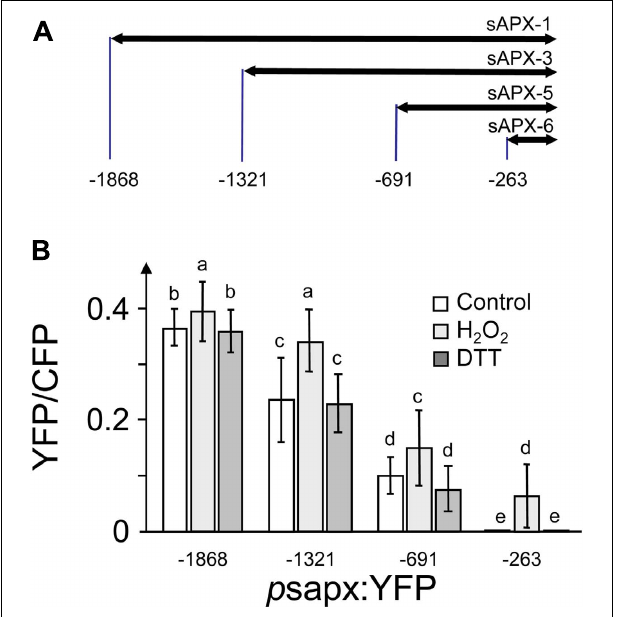
FIGURE 1 | Deletion fragments of the sapx promoter constructed for promoter activation assay in A. thaliana protoplasts. (A) Schematics of the sapx promoter fragments. (B) Expression of theYFP reporter gene fused downstream to the sapx promoter deletion fragments under control, oxidizing (5 mM H 2 O 2 ) and reducing conditions (10 mM DTT) normalized to CFP accumulation under control of the 35S promoter. (1) Promoter fragment p sapx1 ; (2) promoter fragment p sapx3 ; (3) promoter fragment p sapx5 ; and (4) promoter fragment p sapx6 . Intensities of CFP andYFP were quantified in the respective emission channels of the CLSM (Shaikhali etal., 2008).The results are means ± SD of 60–80 protoplasts. Different letters mark groups of significant difference with p < 0.05 (Student’s t